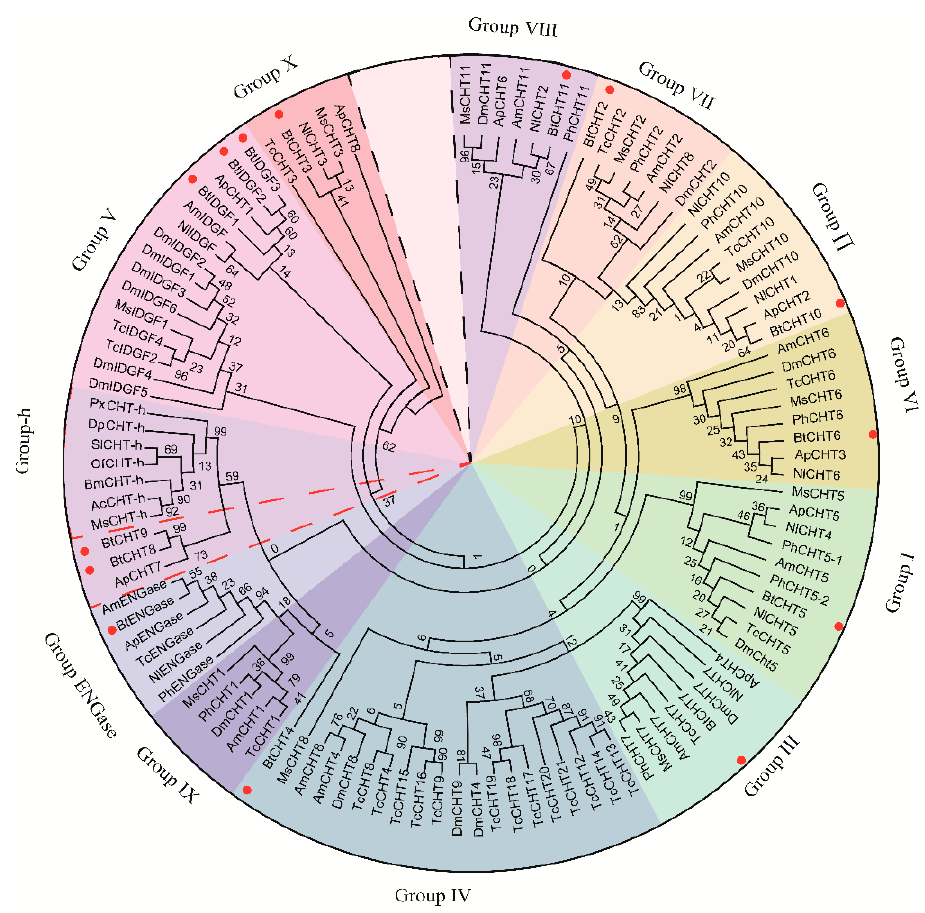
Figure 1. Phylogenetic tree of chitinase-like proteins from eight insect species. MEGA7 software was used to generate the phylogenetic tree with the maximum likelihood method. A bootstrap analysis of 1000 replicates was applied, and bootstrap values are shown in the cladograms. Dm stands for D. melanogaster , Bm for B. mori , Ph for P. humanus , Nl for N. lugens , Ap for A. pisum , Tc for T. castaneum , Am for A. mellifera and Bt for B. tabaci . Ac for Agrius convolvuli , Ms for Manduca sexta , Of for Ostrinia furnacalis , Px for Papilio xuthus , Sl for Spodoptera litura . Chitinase-like proteins from B. tabaci are marked in red dots.